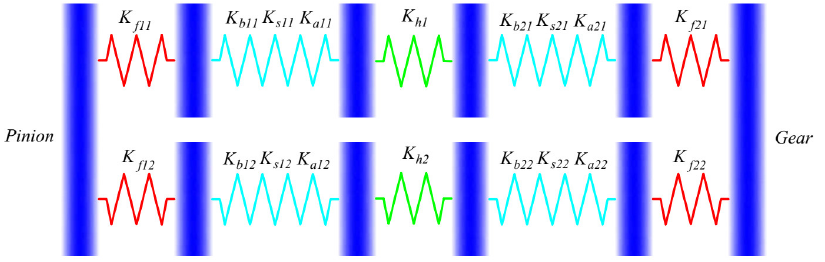
Figure 4. Time-varying mesh stiffness model of the spur gear.